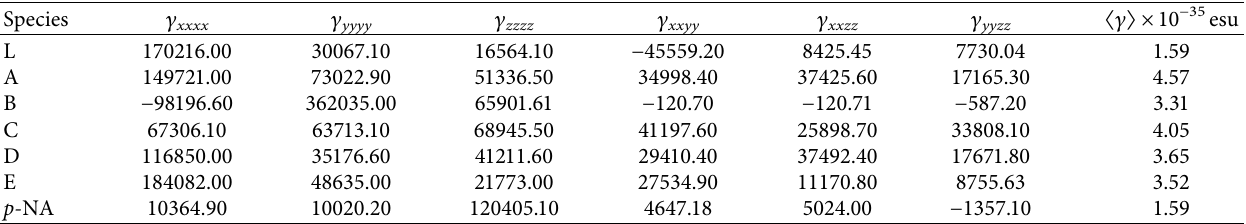
Table 11: Total static average second hyperpolarizabilities ( 〈 c 〉 ) alongside some of its components for ligand, transition metal complexes, and p-NA, calculated at ω � 0 at the wB97xd/6-311++G level of theory. Species